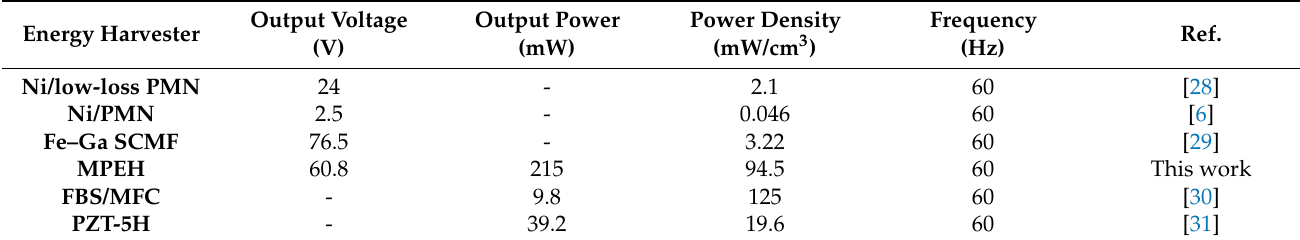
Table 2. Comparison of output performances of existing magneto energy